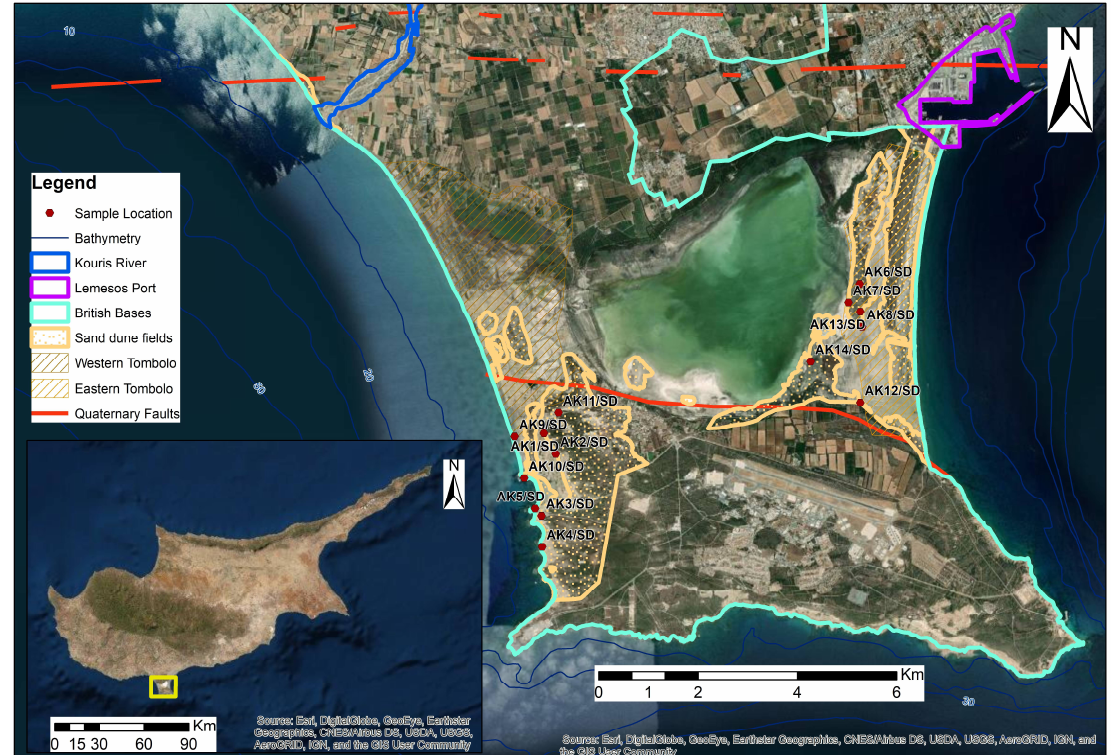
Figure 1. Location of the study area. Red circles represent sample location.